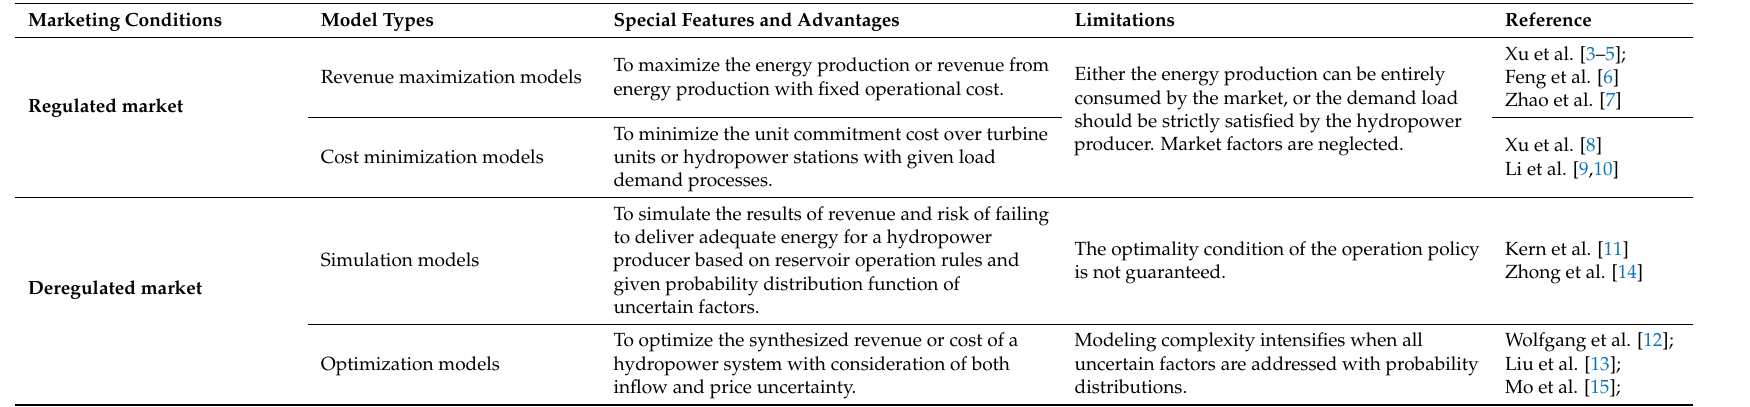
Table 1. The characteristics of reviewed models under different market